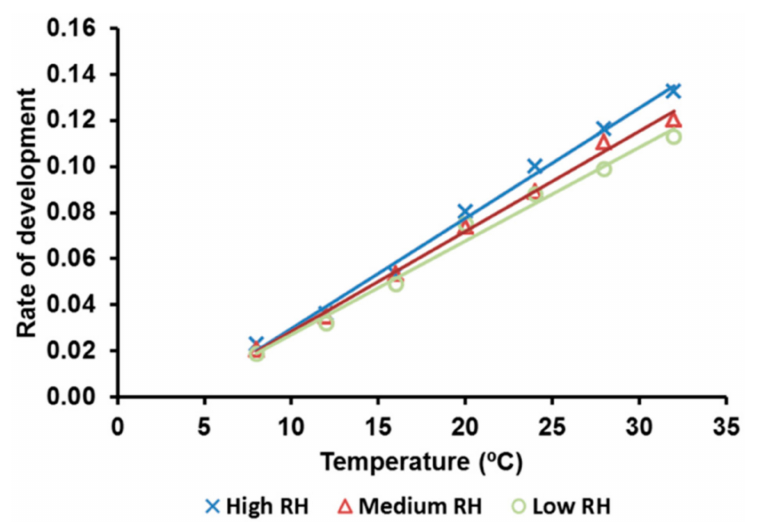
Figure 4. The linear relationship between temperature and the rate of development of the alfalfa weevil eggs, H. postica , at different temperatures and relative humidity (high: 90% < RH < 100%;